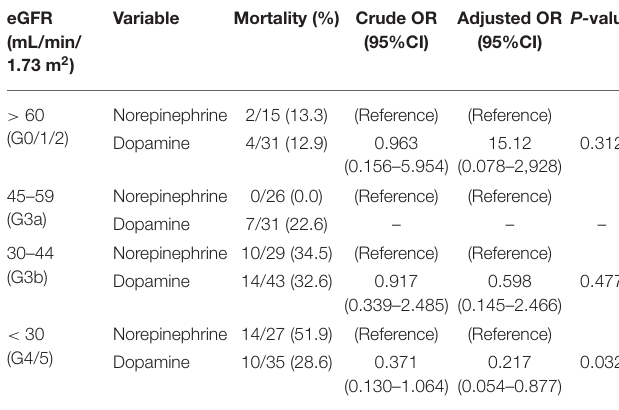
TABLE 3 | Relation between administration of vasopressor agents and 30-day Mortality After Hospital Arrival in each